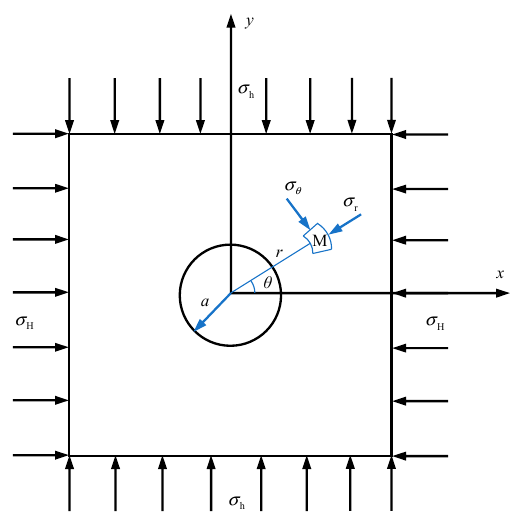
Figure 2. The mechanical model of hydraulic fracturing stress measurements.